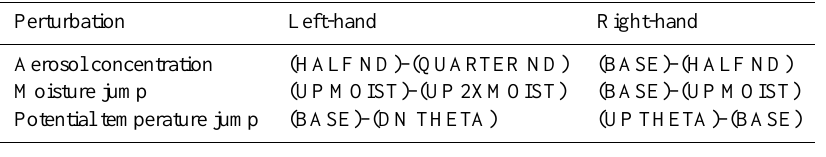
Table 5. Expressions depicting how the two hourly-averaged responses (leftmost and rightmost for each hour) are computed for each pertur- bation in Fig. 10 to 13. The expressions in the rightmost column use the simulation names described in Sect. 5. Perturbation Left-hand